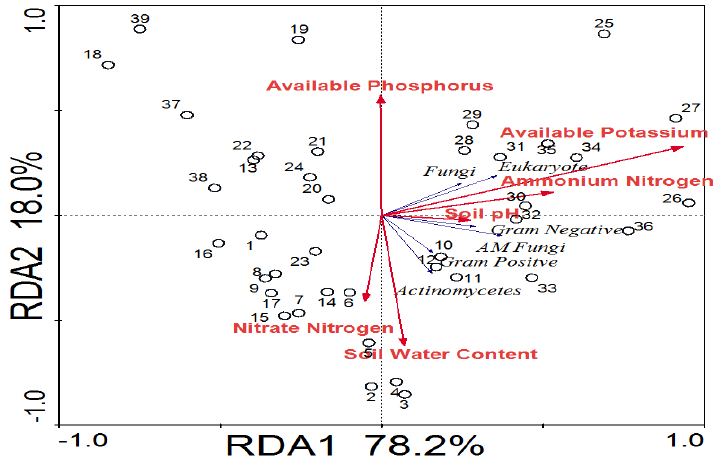
Figure 7. Redundancy analysis (RDA) of relationships between microbial community structures, physcochemical properties, and environmental factors. The variations in the cumulative interpretation of the first and second axes were 96.2%. The first axis indicates the variables in 78.2%, and the second axis explains the variables in 18.0%.